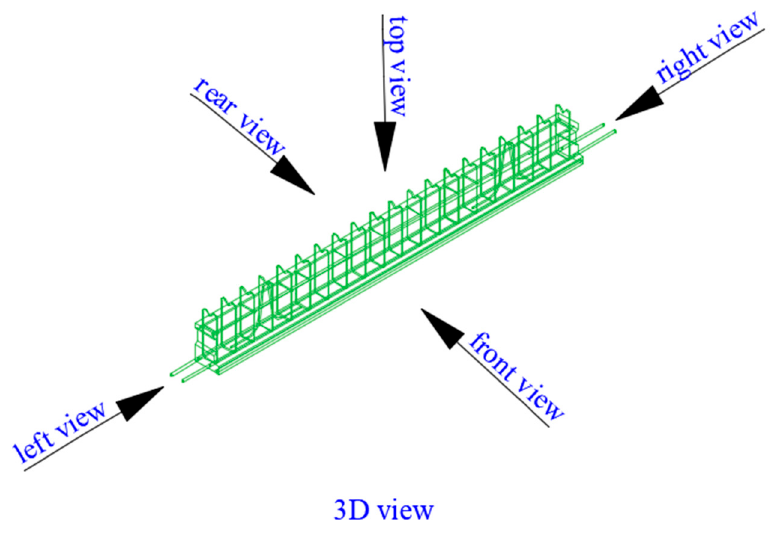
Figure 5. 3D view of CG-2 composite beam.